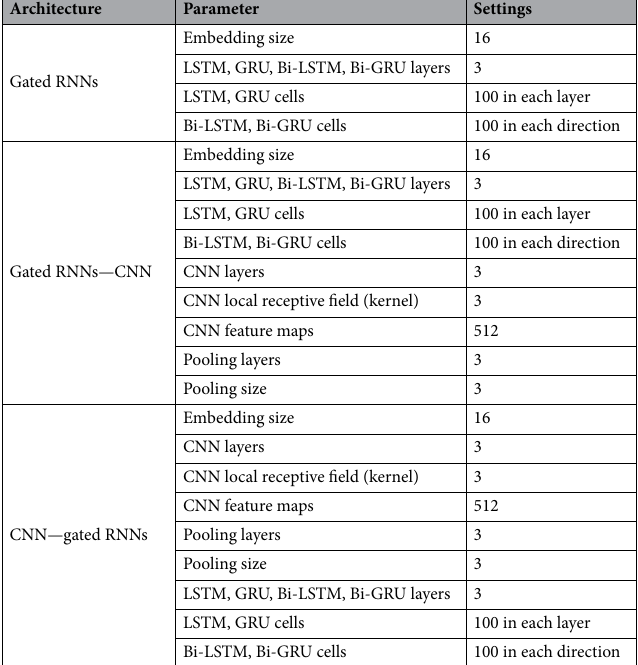
Table 2. Network settings for feature detection layers.